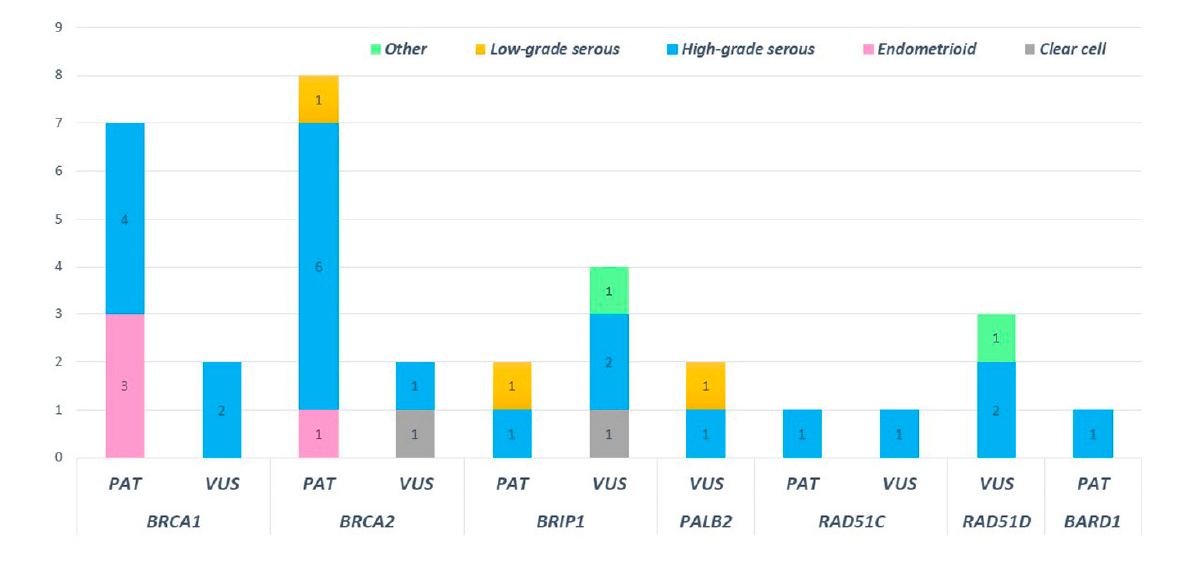
Figure 7. Distribution of pathogenic and uncertain significance variants according to the ovarian cancer histology of our cohort.